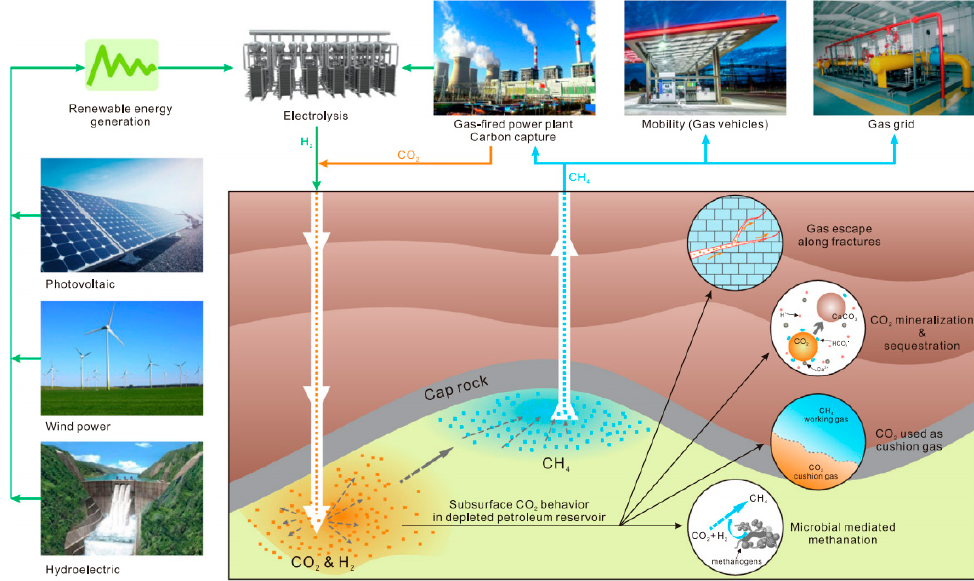
Figure 2. Simplified concept of biomethanation [55].